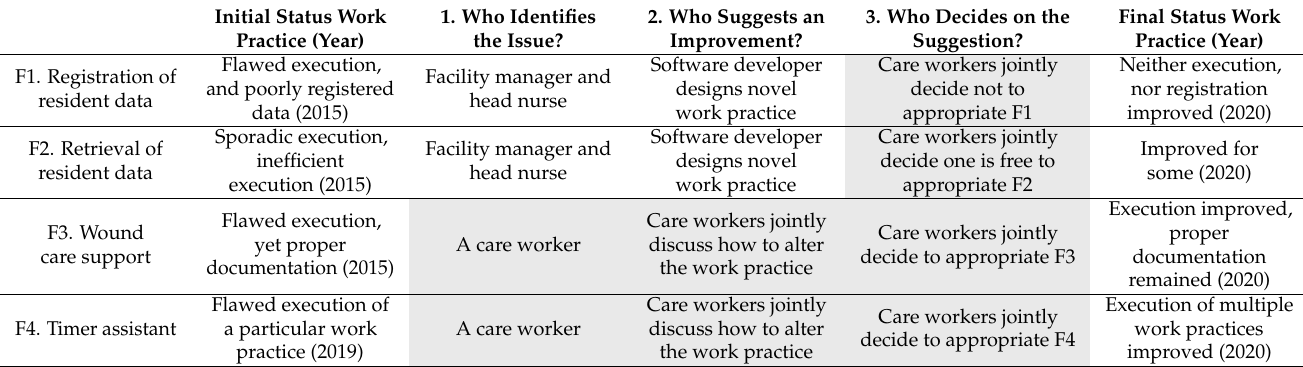
Table A3. Timeline of PDA appropriation and continuously improving work